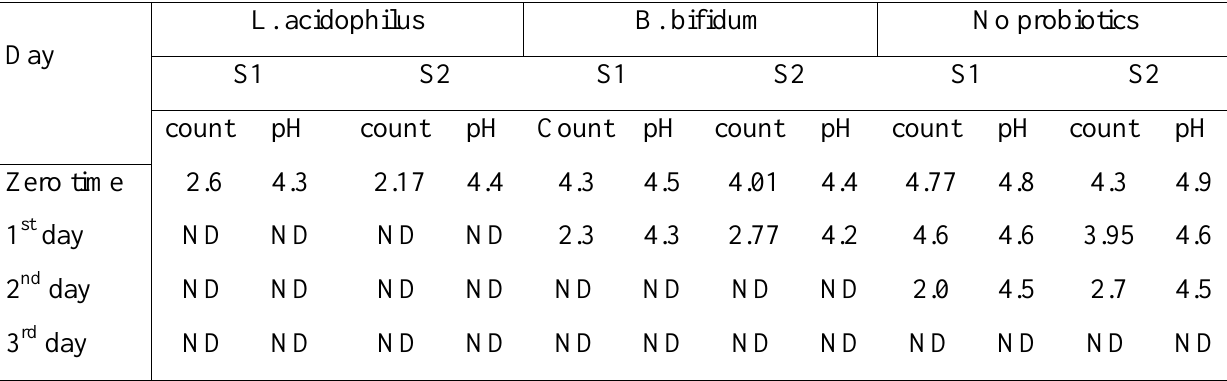
Table 4: Survival of H. pylori in yoghurt supplemented with L. acidophilus and B. bifidum